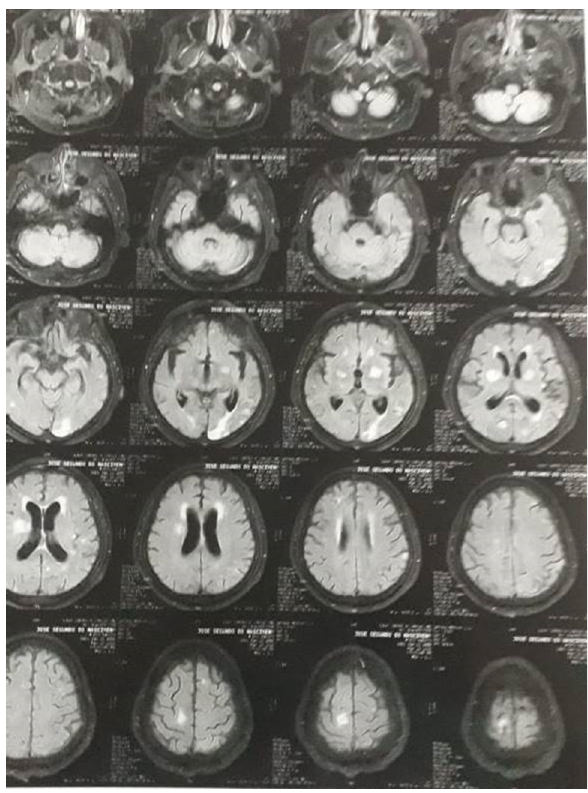
Figure 1. Patient’s original neuroimaging scan shows extensive bilateral damage to parietal, temporal and occipital areas, cortical and subcortical, smaller bilateral lesions on the basal ganglia cortical-subcortical transitions and on the parasagittal region of the left cerebellum hemisphere. All lesions show evidence of slight periventricular vasogenic edema and deposits of calcium and blood degradation byproducts, without highlights post-contrast application nor significant expansive effects. Other physiological alterations include a localized lesion on the left side of the bulbus, non-hypertensive dilation of the ventricular supratentorial system and compensatory enlargement of brain fissures, cortical sulci and basal cisterns. The diagnostic impression by the imaging professional is that most of the lesions and calcium/blood degradation deposits could be explained by the recent (at the time) cerebral toxoplasmosis infection.